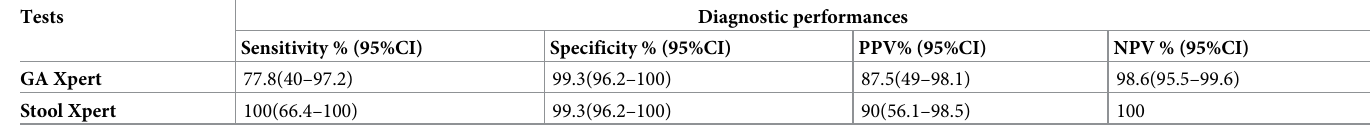
Table 3. Diagnostic performance of GA Xpert and stool Xpert using culture as a reference standard.